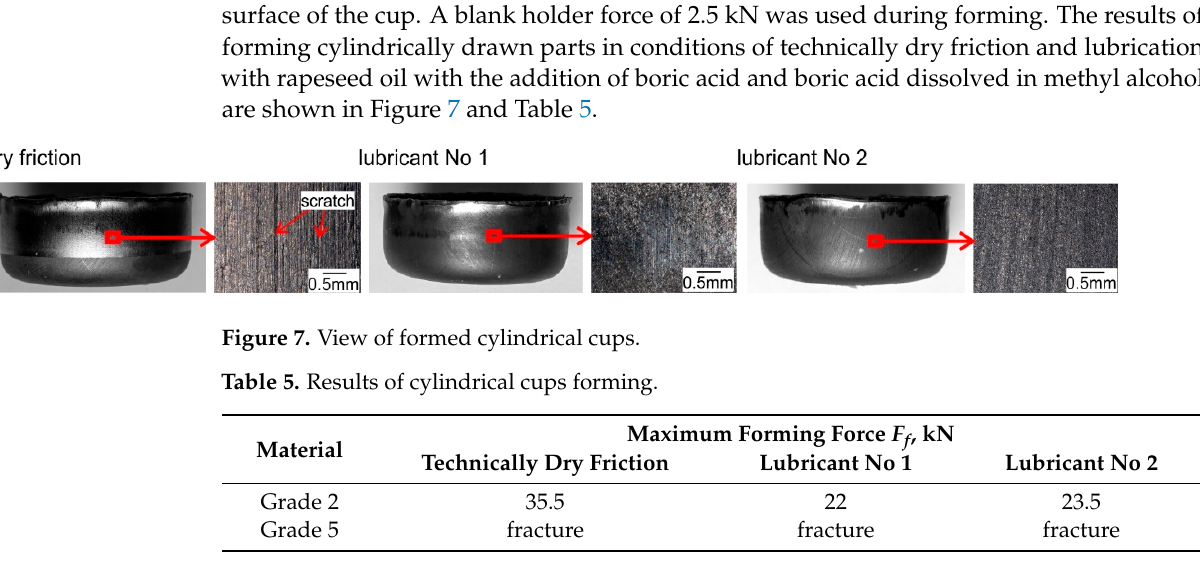
Figure 9. Grade 2 drawn part formed with lubricant No. 2. The use of lubricants with the addition of boric acid during the formation of titanium sheets enables not only the acquisition of drawn parts with good surface quality but also, which is very important from the point of view of environmental protection, the elimina- tion of the previously used mineral oil-based lubricant from the technological process. Mineral oil-based lubricants are difficult to wash off the surface of the drawn parts, and their disposal is expensive. Meanwhile, boric acid is a low-toxic substance. It is only slightly absorbed through intact skin, and because it has antibacterial properties, it is often used in medicine. Boric acid is only poisonous if taken internally or inhaled in large quan- tities. The proposed lubricants can be effectively washed off the drawn part surfaces: in the case of a 25% solution of boric acid in methyl alcohol with hot water, and in the case of boric acid sprayed on a layer of rapeseed oil with hot water and the addition of a bio- degradable detergent, e.g., dishwashing liquid. 3.4. FEM Simulation of Forming Hat-Shaped Part Numerical simulations of the forming process of the hat-shaped parts were carried out using the PAMStamp 2G software based on the finite element method (FEM). This software was specially dedicated to the simulation of sheet metal forming processes. The numerical model of the forming process was developed based on the actual tool and pa- rameters of the forming process (Figure 2b) used in the experiment. The following bound- ary conditions were assigned to the individual parts of the tool: all degrees of freedom have been removed from the die; the punch and the blank holder can move in the direction of the Z axis; the velocity vector was assigned to the punch; and the force vector F b - h = 12.5